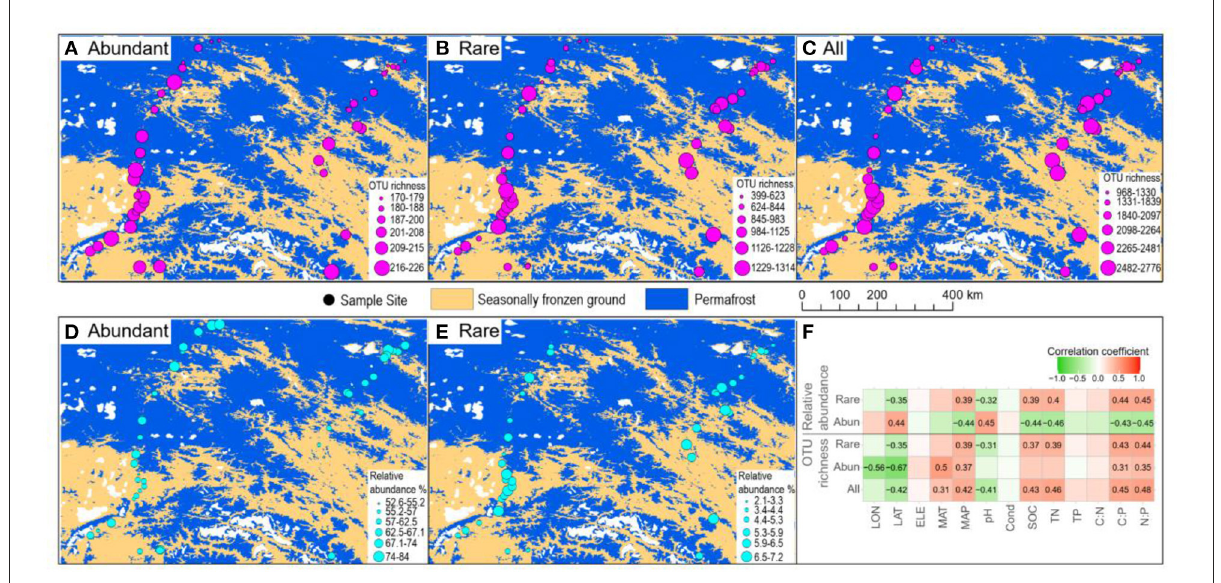
FIGURE3 Spatial patterns of abundant and rare taxa. (A–C) Spatial distribution of the OTU richness in terms of abundant, rare, and all the taxa. (D,E) Spatial distribution of the relative abundance of abundant and rare taxa. (F) Spearman’s correlation between OTU richness and relative abundance of abundant and rare taxa vs. environmental variables. Only significant ( p < 0.05 ) correlations are shown in the number, which is the correlation